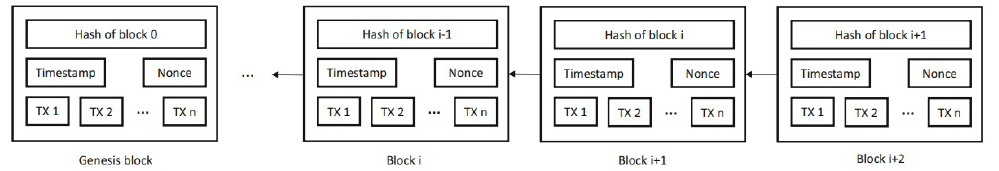
Figure 1. Blockchain structure. (Zheng et al. 2016